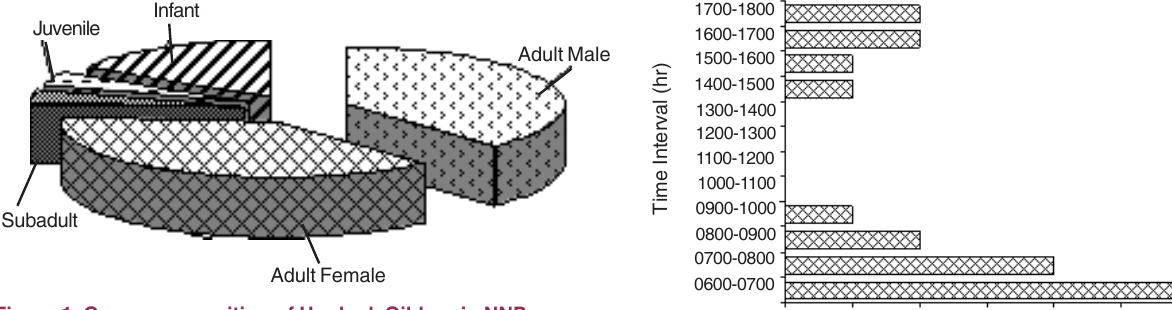
Figure 1. Group composition of Hoolock Gibbon in NNP